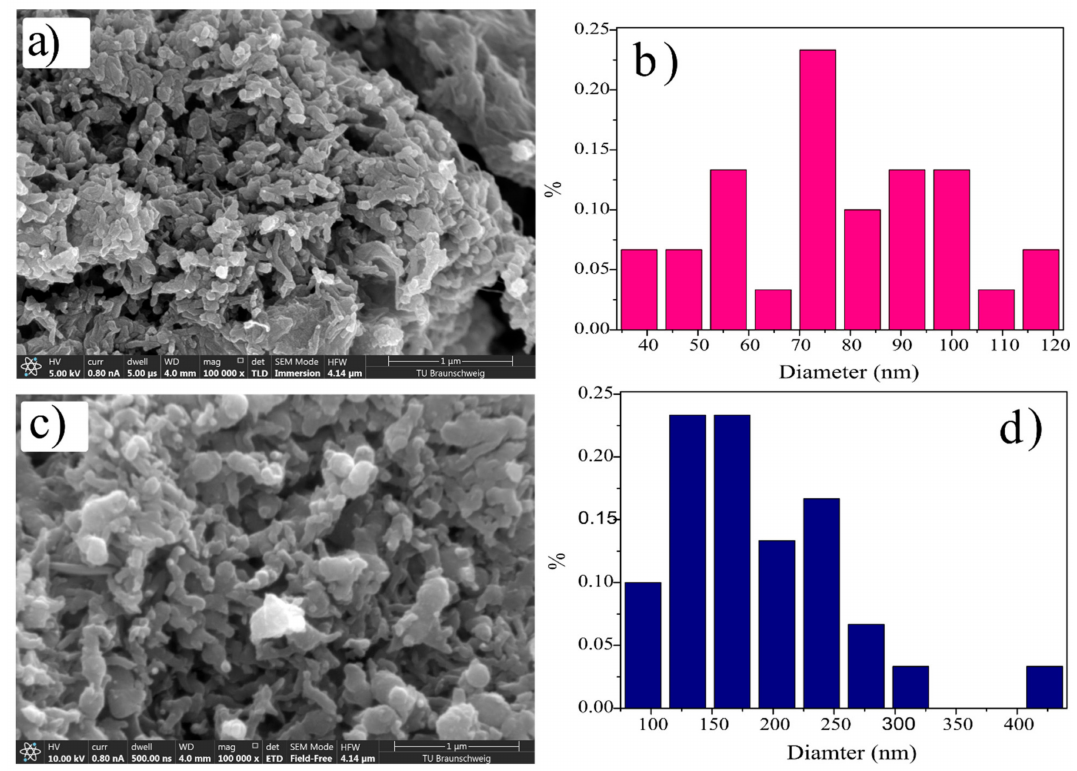
Figure 4. ( a ) SEM image and ( b ) particle size distribution histogram of ds@PANI / GO; ( c ) SEM image and ( d ) particle size distribution histogram of cs@PANI / GO. Table 1. Particle size distribution of ds@PANI / GO composite and cs@PANI / GO composite. S.